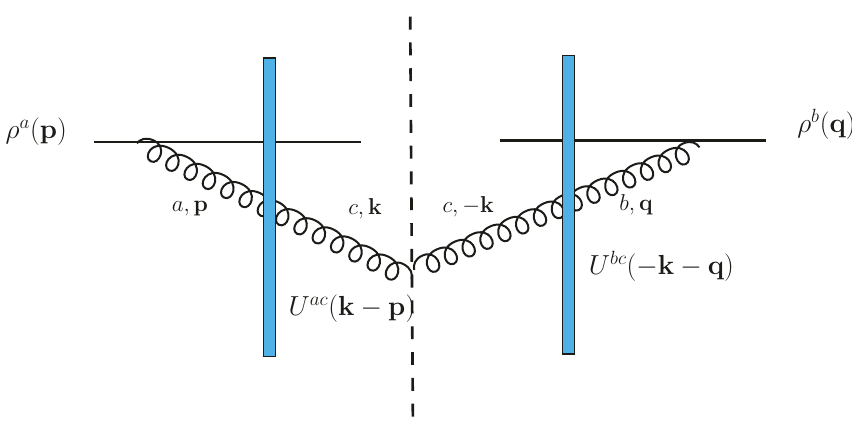
Figure 4 . Color structure for | M | 2 . Two gluons lines cross the target nucleus indicating the (1) two Wilson lines. The dashed line separates the amplitude on the left and the complex conjugate amplitude on the